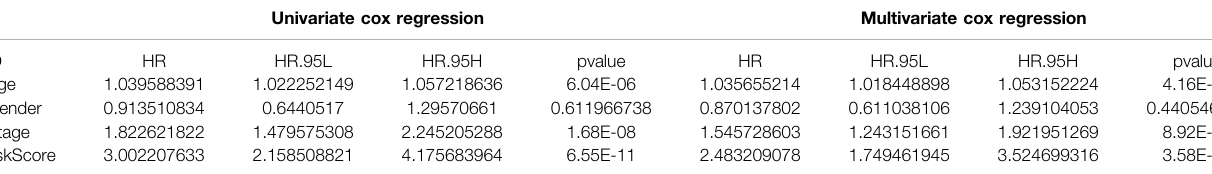
TABLE 1 | Univariable and multivariable Cox analysis of clinical characteristics and riskScore in the TCGA-BLCA cohort. Univariate cox regression